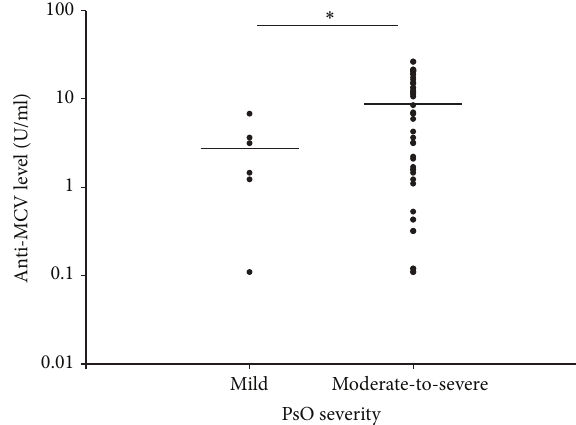
Figure 2: Anti-MCV titers are higher in patients with moderate- to-severe psoriasis than in mild psoriasis. The plots show the anti- MCV levels in moderate-to-severe (previously or currently treated with systemic or phototherapy) and mild (never received systemic or phototherapy) PsO patients. The horizontal lines indicate the mean levels of anti-MCVs. ∗ The difference between the data on mild and the moderate-to-severe psoriasis PsO groups ( 2.73±2.37 U/mL versus 9.73 ± 7.54 U/mL), respectively, was significant ( 𝑃 < 0.05 ).